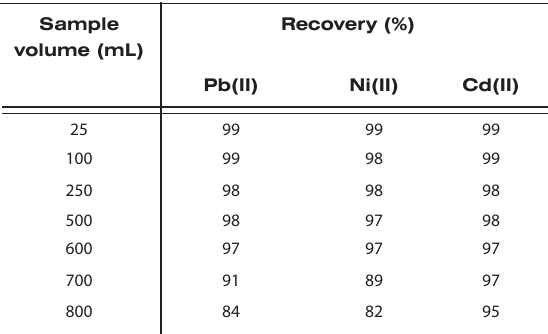
Table 2. Influence of the sample volume on the recovery of analyte ions